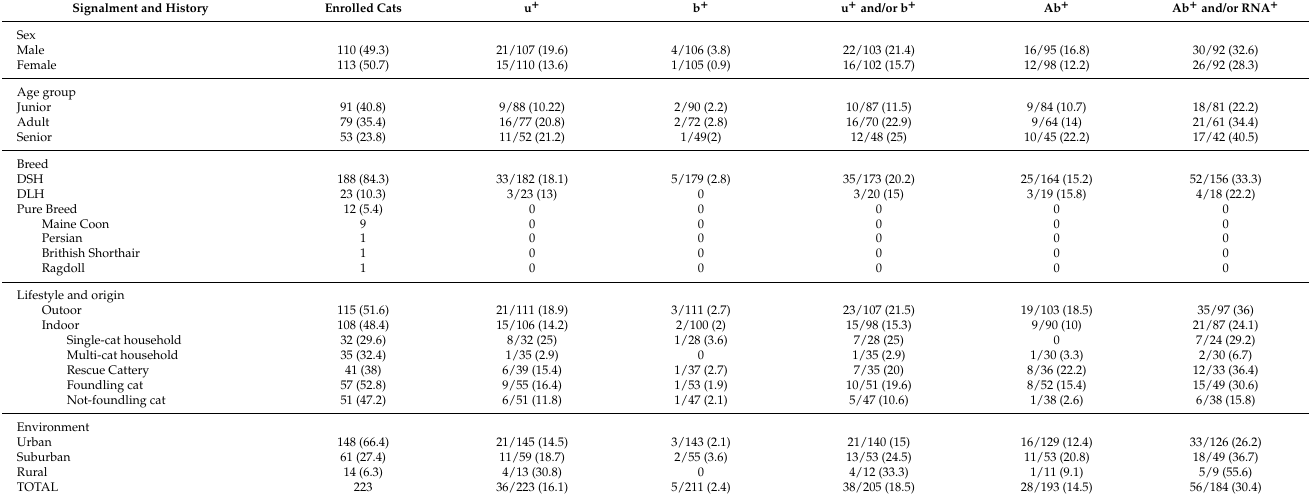
Table 2. Data from signalment and history [ n (%)] of enrolled cats and cats positive to FeMV according to their positivity with PCR from urine (u + ), blood (b + ), urine and/or blood (u + and/or b + ), antibody positivity (Ab + ), antibody and/or qPCR FeMV (Ab + and/or RNA + ). DSH = domestic shorthair; DLH = domestic longhair. SignalmentandHistory